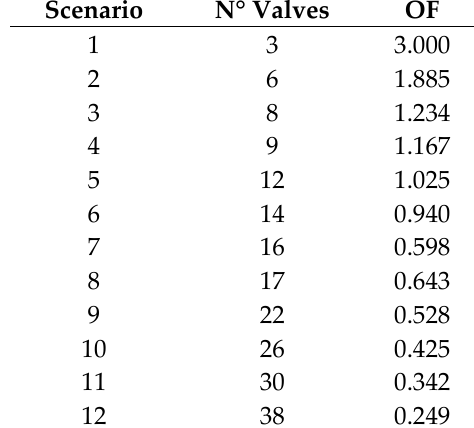
Table 4. OF Values for the different scenarios.